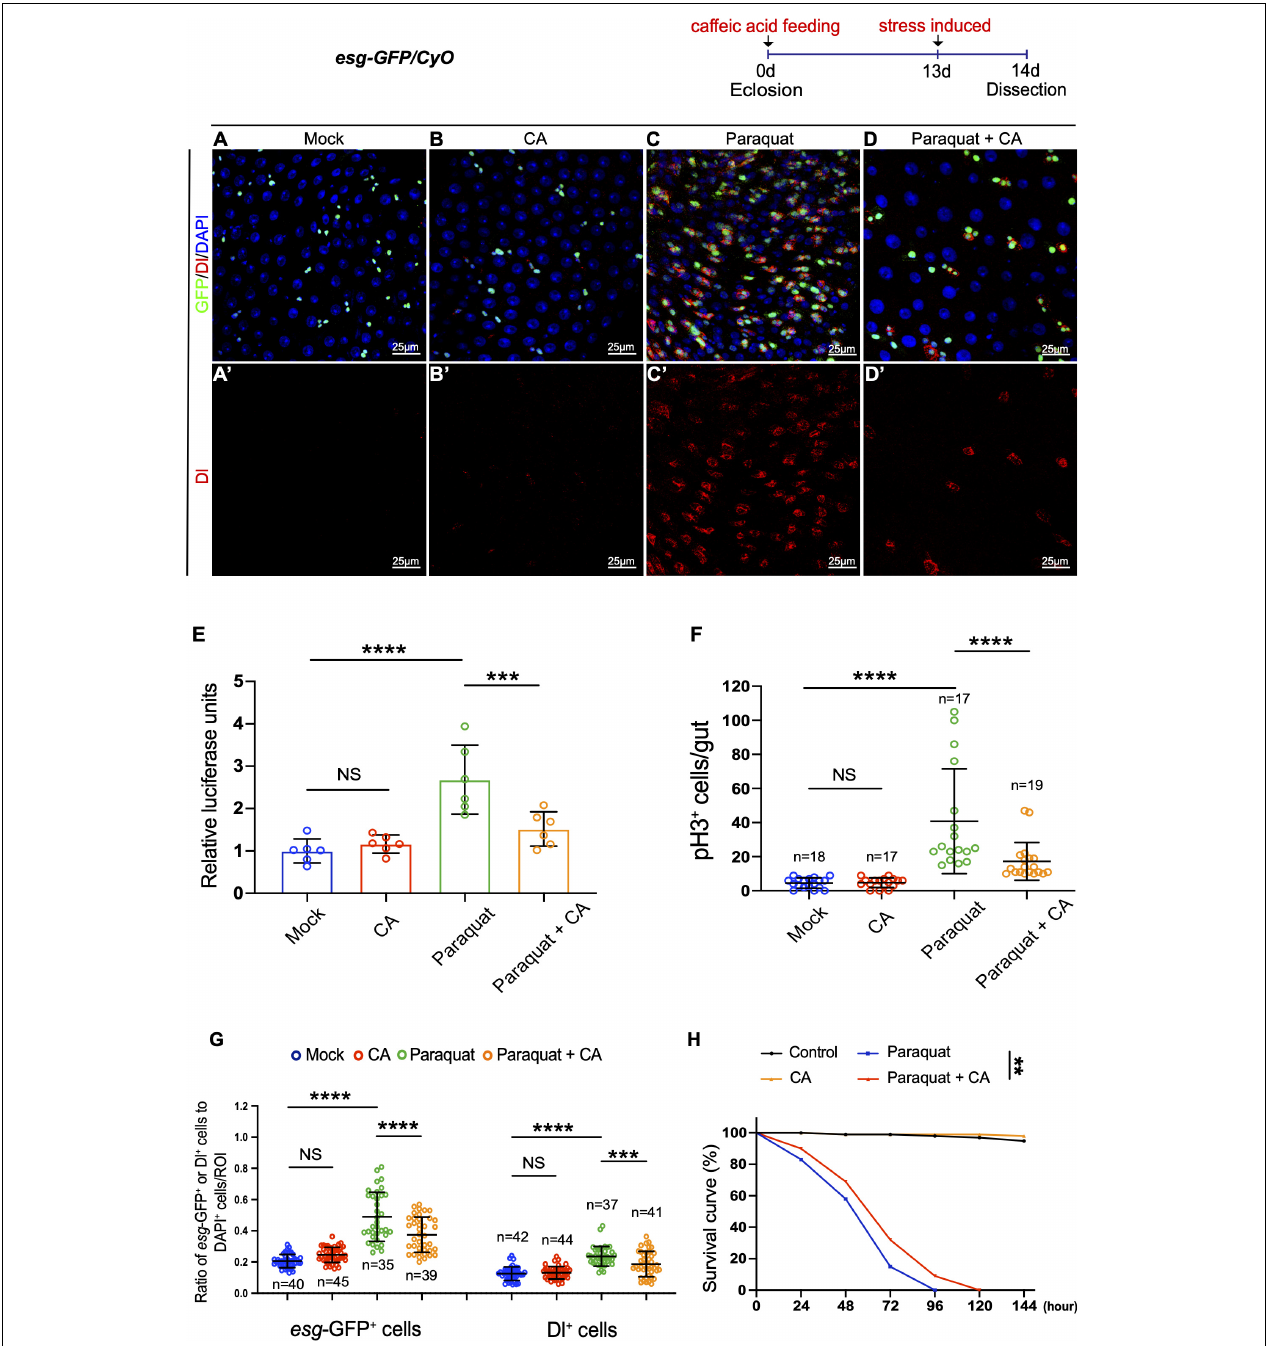
FIGURE 3 | Caffeic acid (CA) supplementation prevents stress-induced ISC hyperproliferation and improves stress tolerance in Drosophila . (A–D) Immunofluorescence images of the R4 region of dissected midguts of 14-day Drosophila . (A) Mock represents the control. (B) Caffeic acid treatment. (C) Paraquat. (D) Paraquat with CA supplementation. esg- GFP (green; ISC, and EB markers) and Dl (red; ISC marker). Panels (A–D) represent merged images and panels (A’–D’) are for Dl (red) only. (E) Quantification of the luciferase activity of midguts of Mock, CA, Paraquat, and Paraquat with CA treated flies. Error bars represent the SD of six independent experiments. (F) Quantification of the number of pH3 + cells in experiments (A–D) . N (from left to right) = 18, 17, 17, and 19. (G) Quantification of the number of esg -GFP + and Dl + cells in experiments (A–D) . N (from left to right) = 40, 45, 35, 39, 42, 44, 37, and 41. (H) Survival percentage of flies with (marked with the red curve) and without (marked with the blue curve) CA supplementation under paraquat treatment. N = 100 flies per group. Three independent experiments were repeated. DAPI stained nuclei are shown in blue in panels (A–D) . Scale bars represent 25 µ m in panels (A–D) . Error bars represent SDs. One-way ANOVA test, Log-rank test for panel (H) . ** P < 0.01, *** P < 0.001, **** P < 0.0001, and non-significant (NS) represents P > 0.05.